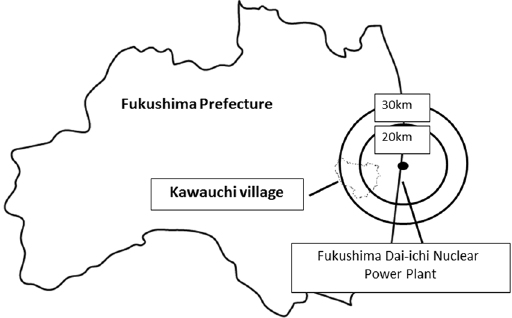
Figure 1. Location of Kawauchi village, Fukushima Prefecture, Japan.